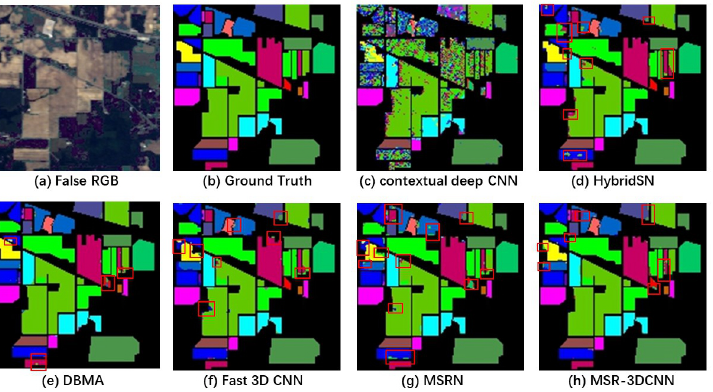
Figure 11. Results of the IP dataset using 10% samples for trainingand ( 9 × 9 ) patch size.